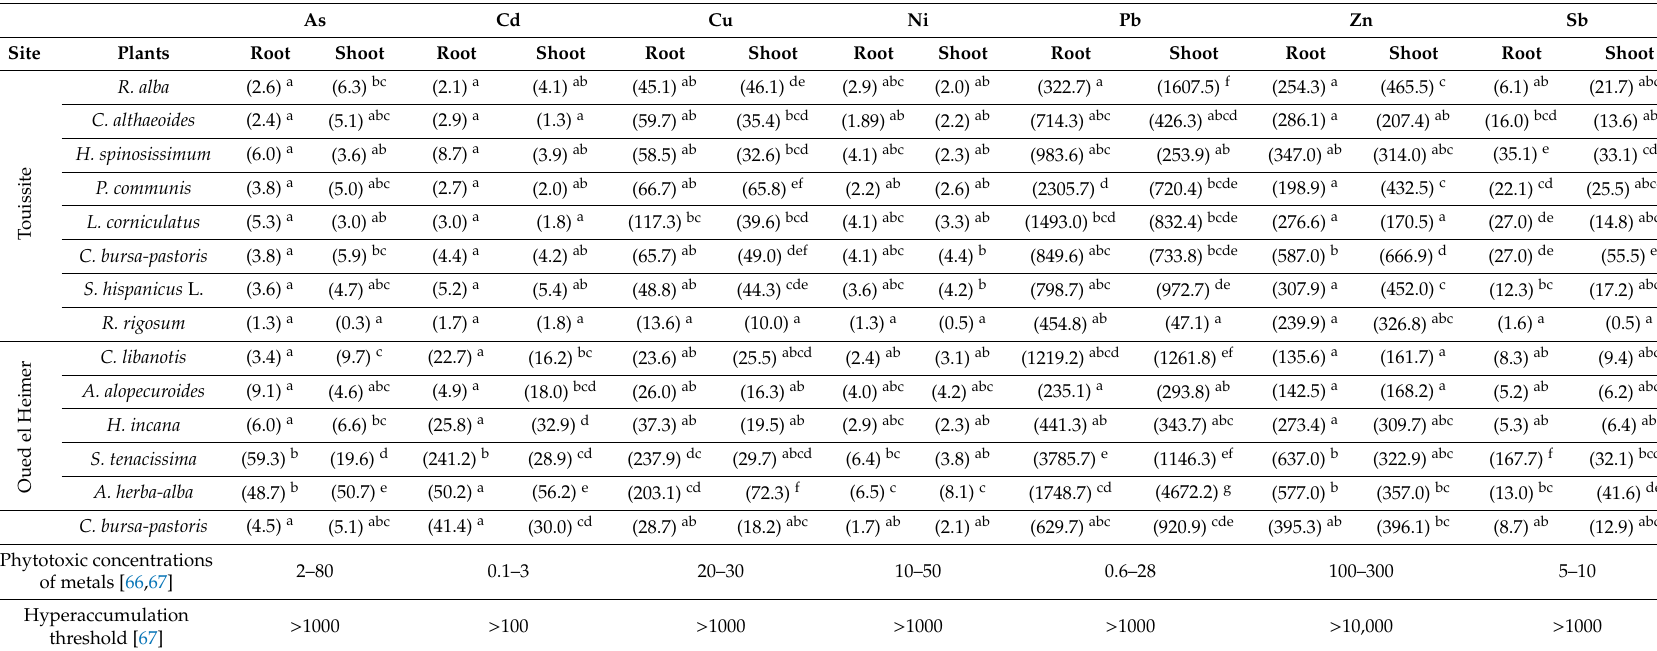
Table 3. Pair-wise di ff erences of heavy metals concentrations (mg kg − 1 DW) in the roots / shoots of plants collected from the studied sites in the oriental region of